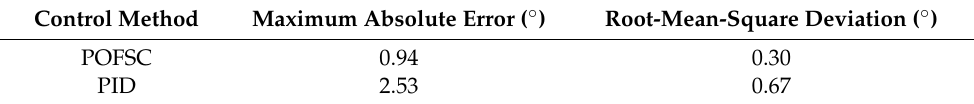
Table 8. Error comparison using the POFSC and PID for the shoulder joint (30°).